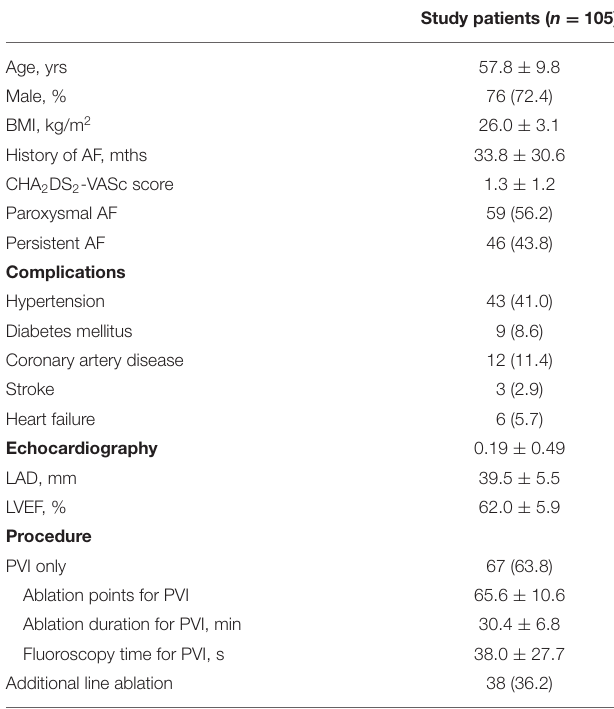
TABLE 1 | Baseline clinical and procedure